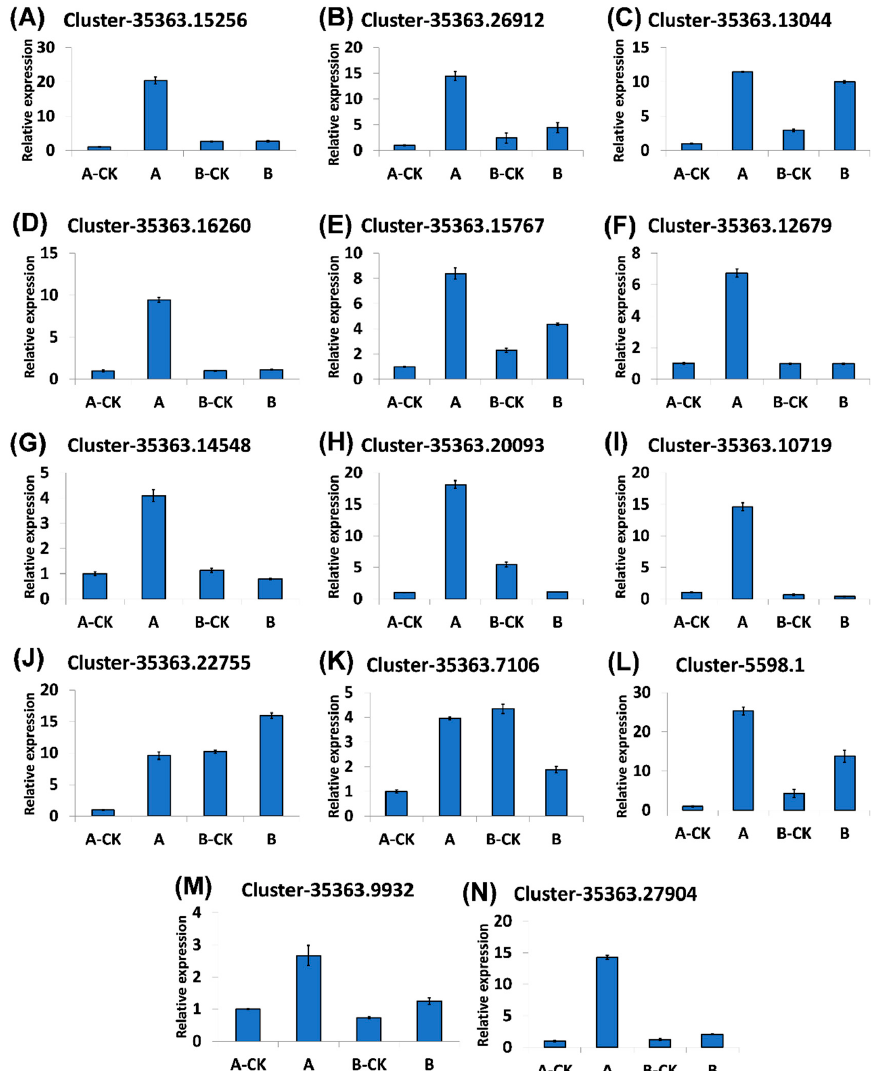
Figure 6. Validation of immunity related genes by Real-Time Quantitative PCR in both resistant and susceptible varieties. ( A ) WRKY-71 , ( B ) WRKY-41, ( C ) WRKY-47 , ( D ) ERF-1 , ( E ) ERF-RAV2 , ( F ) WRKY-22 , ( G ) WRKY-18, ( H ) HSTF-1 , ( I ) MYB-74 , ( J ) MYP-ETC1 , ( K ) bZIP-53, ( L ) bHLH-41 , ( M ) bHLH-49 ( N ) CERK-1 . Treatments: A-CK (Dawei-un-inoculated control), A (Dawei- inoculated with B. cinerea ), B-CK (Qiuxiang-un-inoculated control), B (Qiuxiang- inoculated with B. cinerea ). Error bars indicates standard deviation.